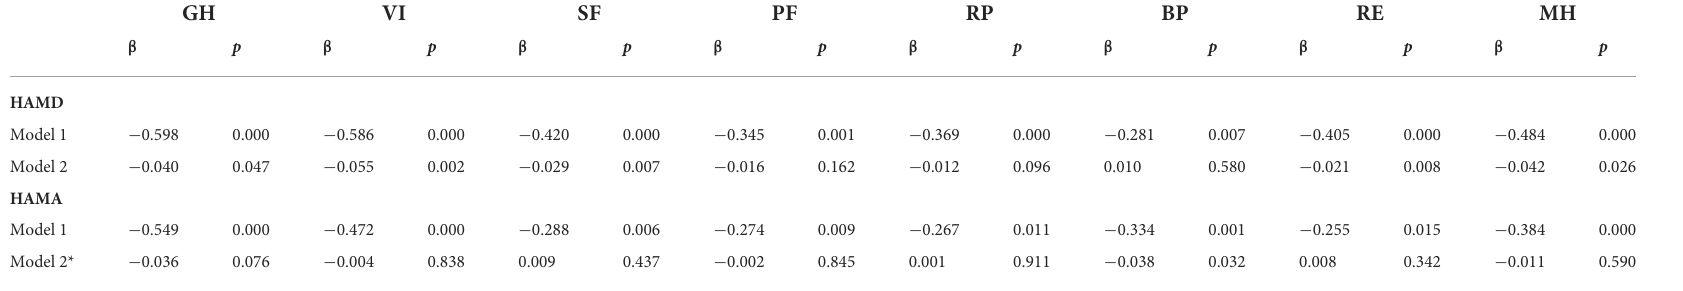
TABLE 5 Multiple linear regression analysis of depression, anxiety, and